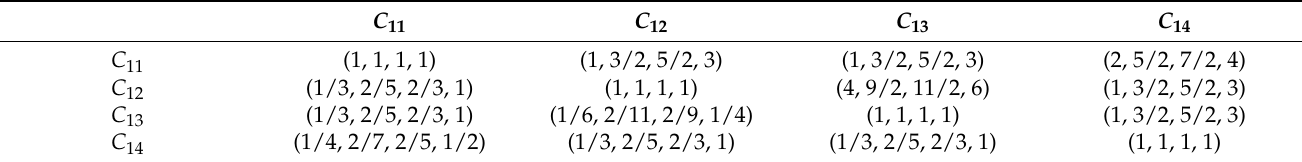
Table A2. Pair-wise comparison matrix of the sub-criterion: aesthetic ( C 1 ).